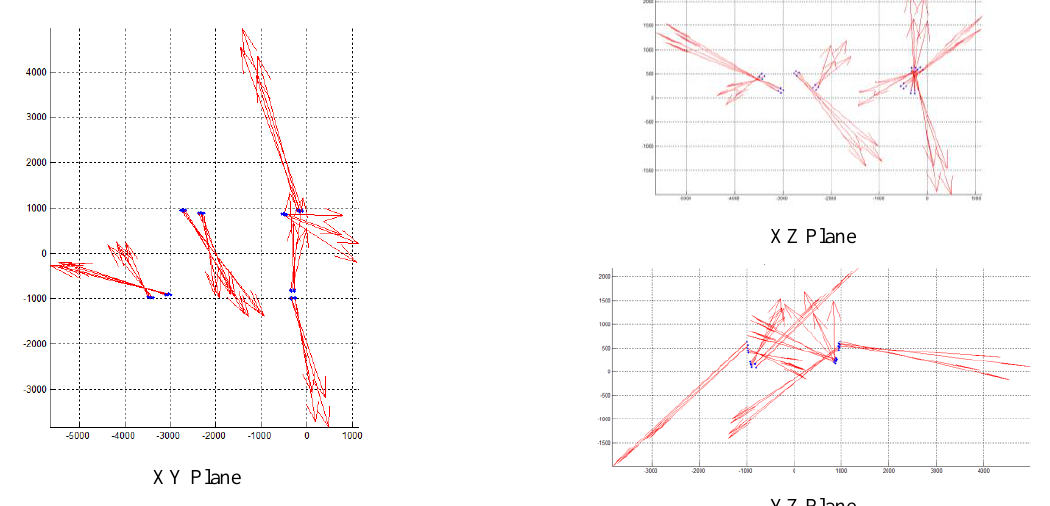
Figure 7. Spatial residuals in mm (scale: 1000) from coarse rigid transformation between the local above-the-water model and the reference